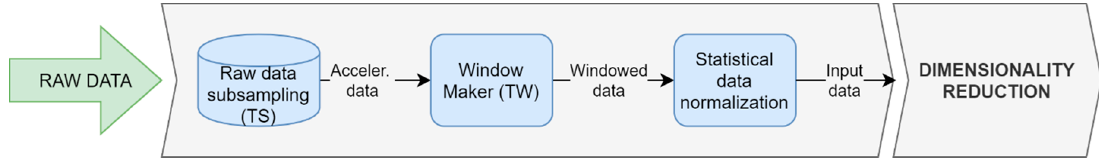
Figure 5. Pre-processing tasks applied to the dataset.